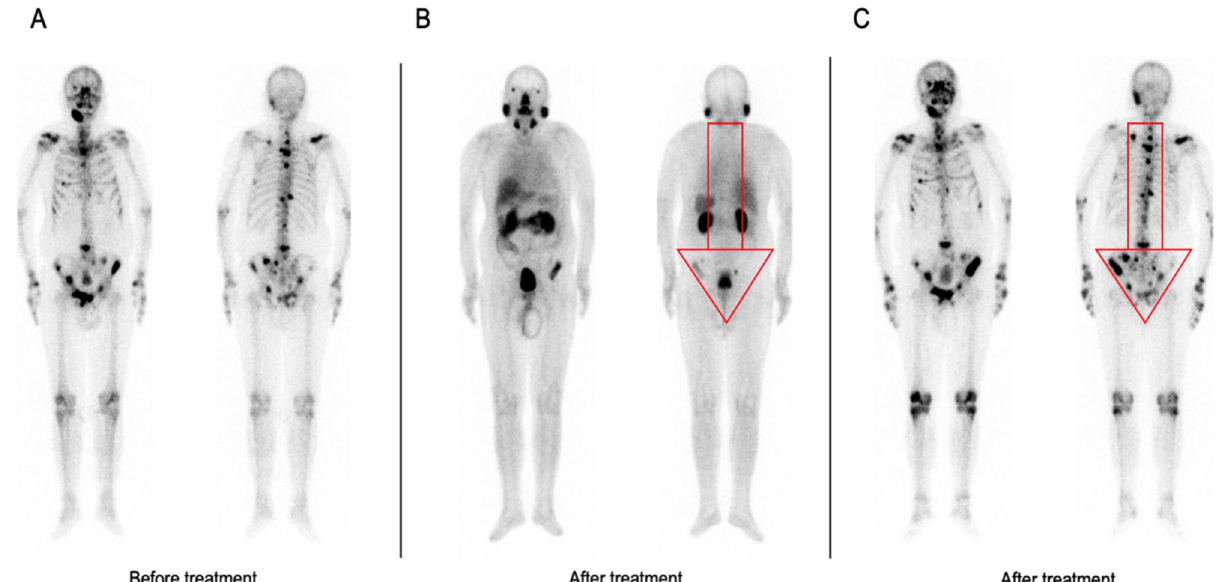
Figure 5. 83-year-old patient with a restaged PCa. The Gleason score was 9, and the PSA level was 587.66 ng/ mL before treatment. ( A ): Whole-body planar 99m Tc-MDP before treatment. ( B ): Whole-body planar 99m Tc- PSMA after treatment. ( C ): Whole-body planar 99m Tc-MDP after treatment. The PSA level was 8.05 ng/mL after 8 months of androgen deprivation therapy (ADT). There was a high degree of inconsistency between the 99m Tc- PSMA scan and 99m Tc-MDP scan after